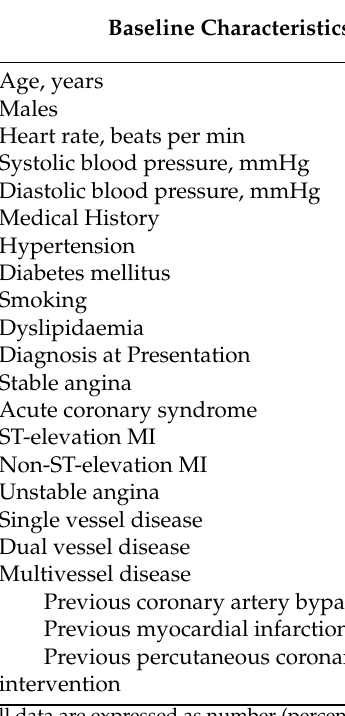
Table 1. Baseline and demographic